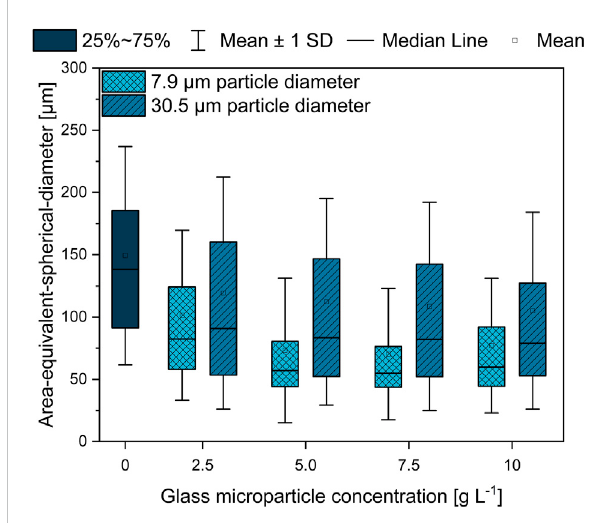
FIGURE 4 Area-equivalent spherical diameter (AESD) of L. aerocolonigenes pellets from 10-day cultivation without glass microparticle addition (control) compared to MPEC with glass microparticle sizes of x 50 =